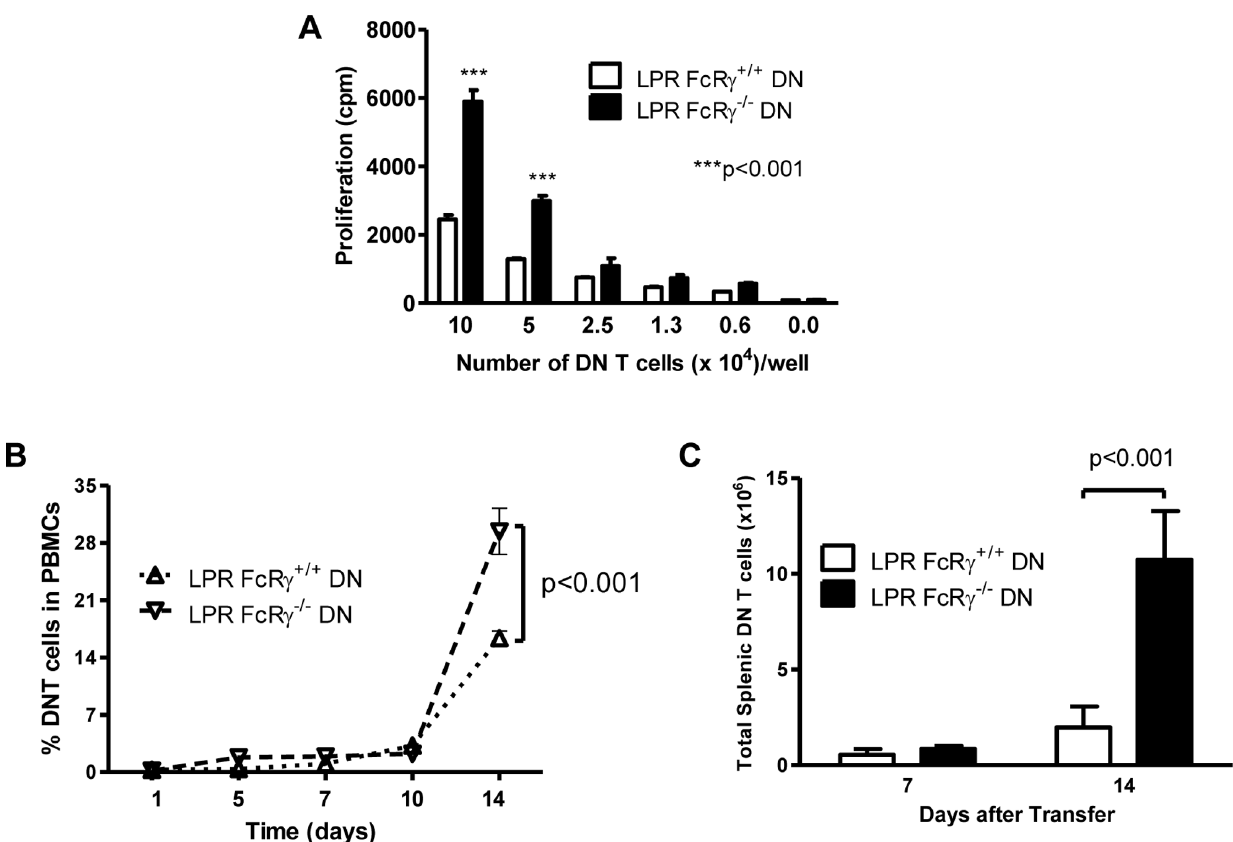
Figure 2. FcR c deficiency results in an increased accumulation of DN T cells. A. B6.LPR.FcR c + / + and B6.LPR.FcR c 2 / 2 mice were given 4 6 10 7 CB6F1 splenocytes intravenously. After 7 days, varying numbers of DN T cells were purified and incubated for a further 3 days with irradiated CB6F1 splenocytes (10 5 /well), after which 1 m Ci 3 H-thymidine was added to each culture. Thymidine uptake, reflecting live proliferated cell number, was determined by scintillation counting. Two-way ANOVA p , 0.0001; **Bonferroni post tests p , 0.001. B. B6.SCID mice (FcR c + / + ) received 10 7 B6.LPR.FcR c + / + (n=3, upright triangles) or B6.LPR.FcR c 2 / 2 (n=3, inverted triangles) DN T cells. On days 1, 5, 7, 10, and 14 blood samples were obtained and peripheral blood mononuclear cells (PBMCs) were stained for TCR b , CD4, CD8, and NK1.1 expression. The percentage of DN T cells